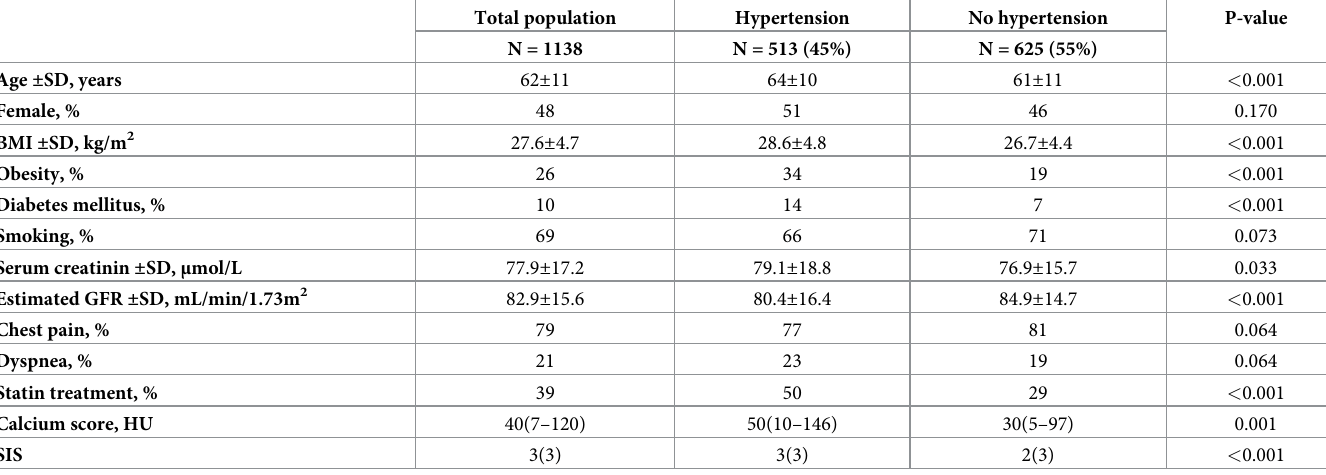
Table 1. Clinical and CCTA characteristics of the total population and in subgroups of patients with and without hypertension.